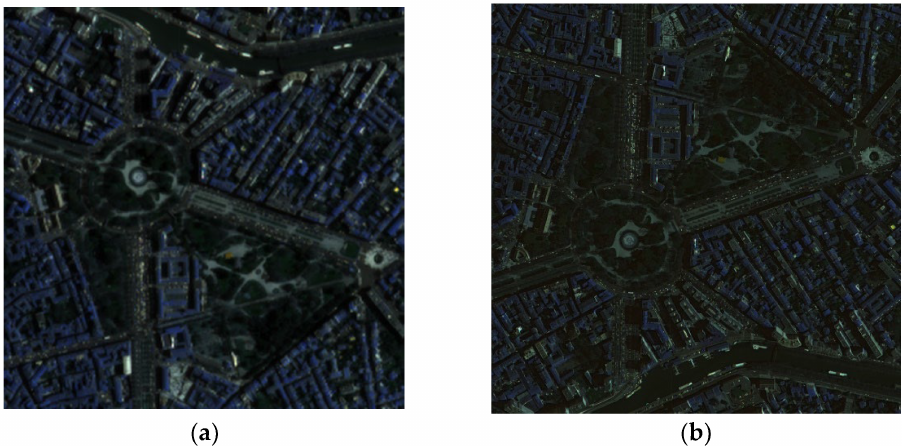
Figure 11. The proposed technology is applied to remote sensing imaging. ( a ) Traditional MIMO transmission. ( b ) The proposed